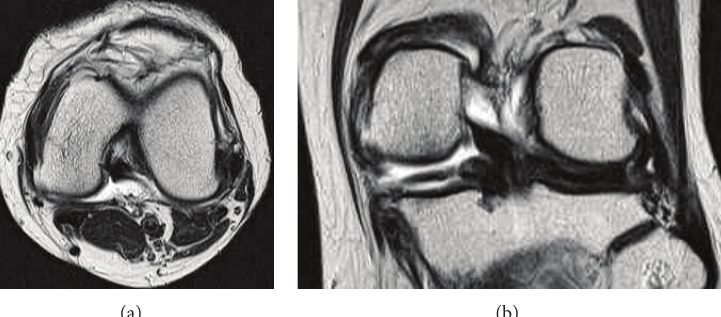
Figure 3: T2 weighted axial (a) and coronal (b) MR images taken 9 months postoperatively demonstrate complete disappearance of the medial meniscal